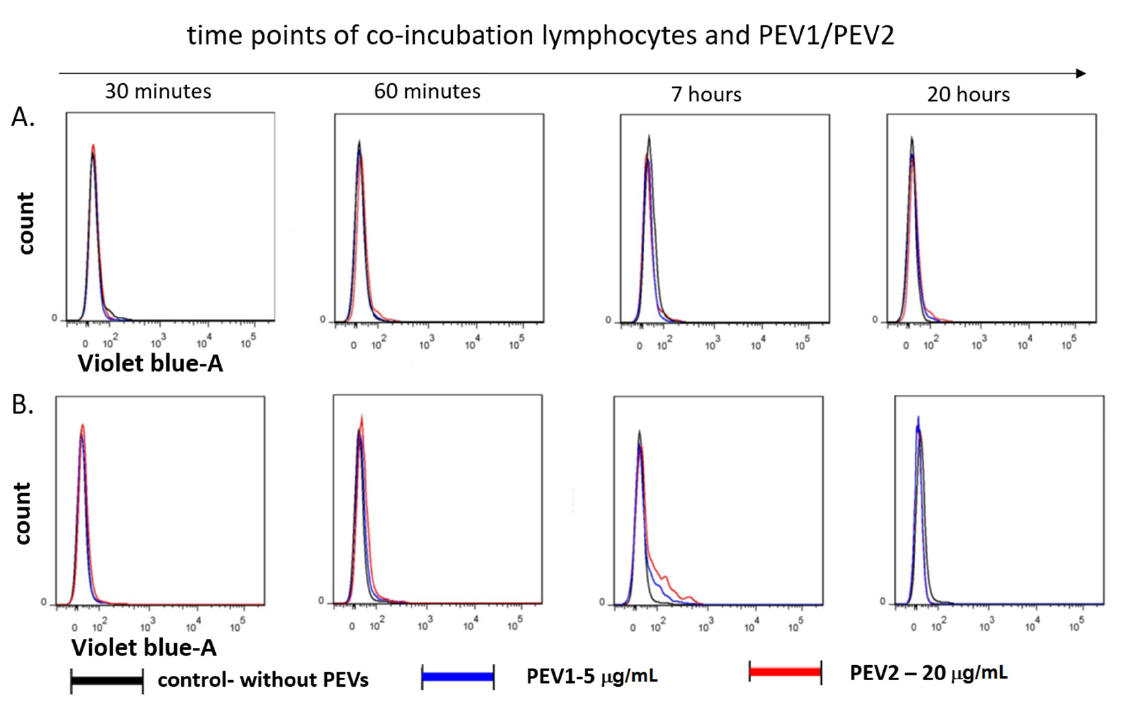
Figure 1. Flow cytometric analysis of the fluorescence transferred by PEVs into lymphocytes. The staining of directly labeled cells and the negative control cells (gray line) after 30 min, 7, and 20 h of incubation are shown. ( A ) The kinetics of PEVs uptaken by B CD21 + lymphocytes and ( B ) PEVs uptake by T CD3 + Lymphocytes.